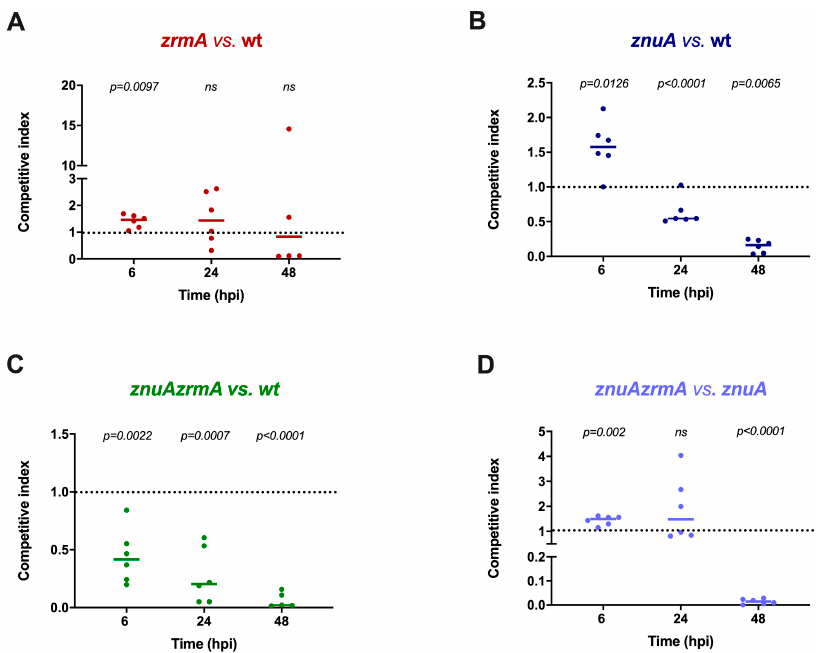
Figure 2. Competition assays of P. aeruginosa strains in zebrafish embryos. ( A ) Competition between zrmA (strain A) and wild-type (strain B). ( B ) Competition between znuA (strain A) and wild-type (strain B). ( C ) Competition between znuAzrmA (strain A) and wild-type (strain B). ( D ) Competition between znuAzrmA (strain A) and znuA (strain B). Each data point represents the competitive index calculated, as described in Section 4.3, on a homogenate of 6 pooled animals. A horizontal straight line indicates the median CI value calculated on the CI values of independent experiments. Statistical analyses were performed by the Student’s t -test ( ns , not significant).